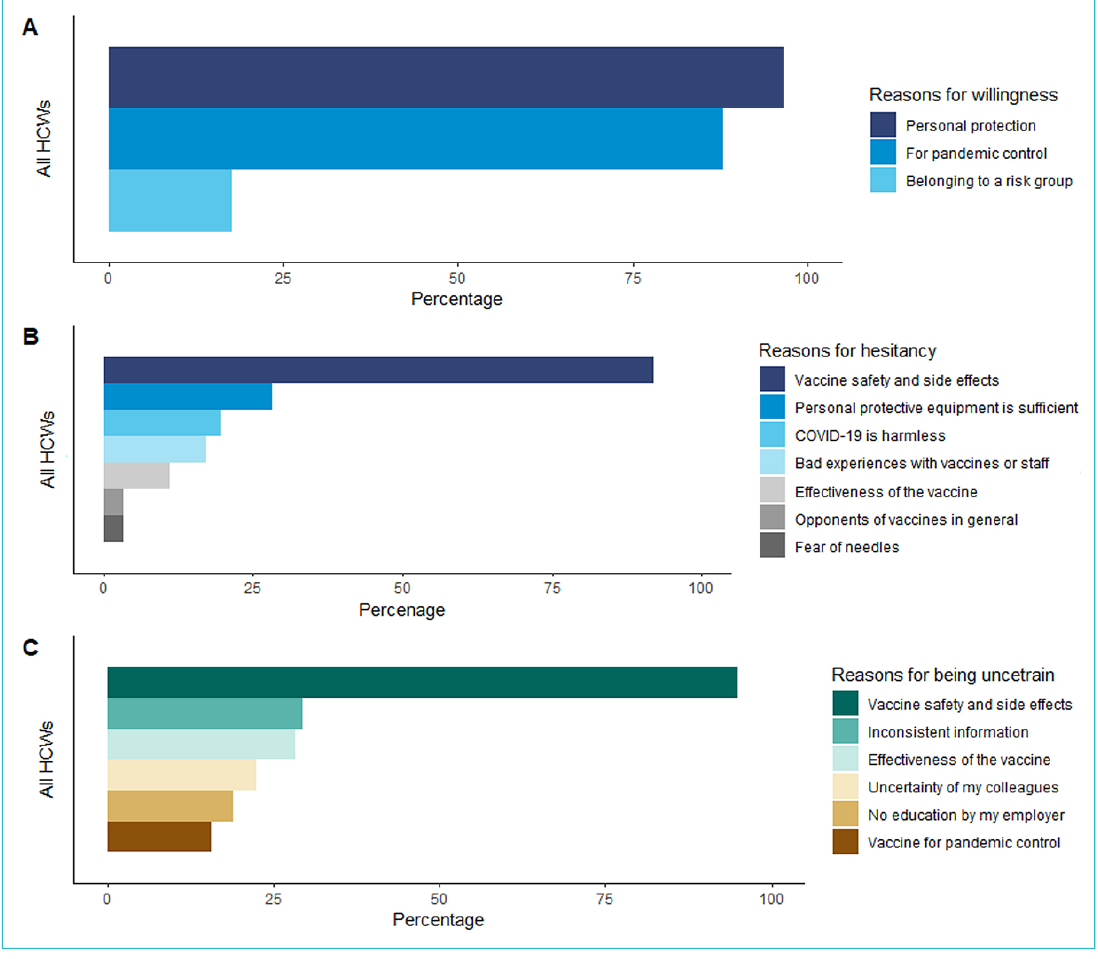
Figure 2: Reasons for vaccine willingness (A), vaccine hesitancy (B) and being uncertain (C) among all healthcare workers. The exact num- bers can be found in table